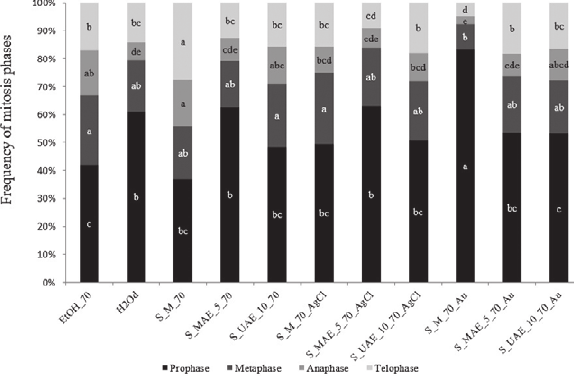
Figure 13. Frequency of mitosis phases (%) in simple extracts of S. officinalis and nanostructured phytochemical complexes (a–e: interpretation of the significance of the differences, by means of the Duncan test, p <